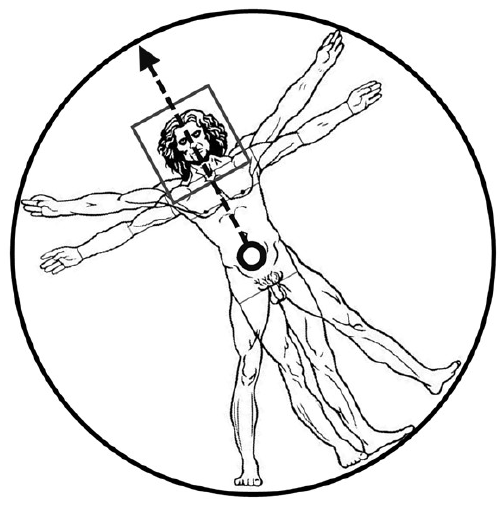
Figure 6. Conceptual Diagram of the body area tracking by BlazePose.